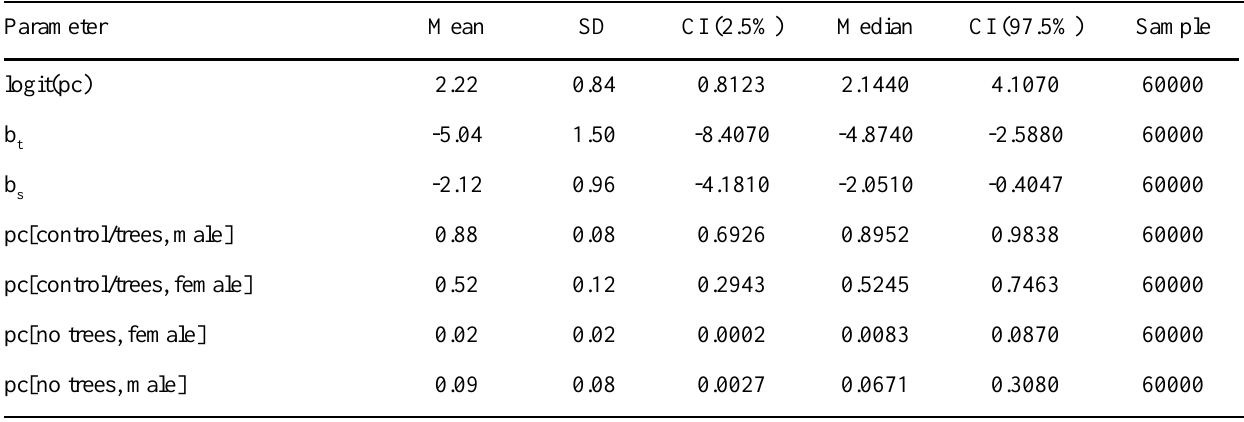
Table 3. The results of the logistic model of the probability that a squirrel glider ( Petaurus norfolcensis ) crosses the road. Parameter estimates for the three terms in the logistic model (logit(pc), bt and bs – see methods) are shown, as well as the resulting predictions for the probability of crossing for the four different